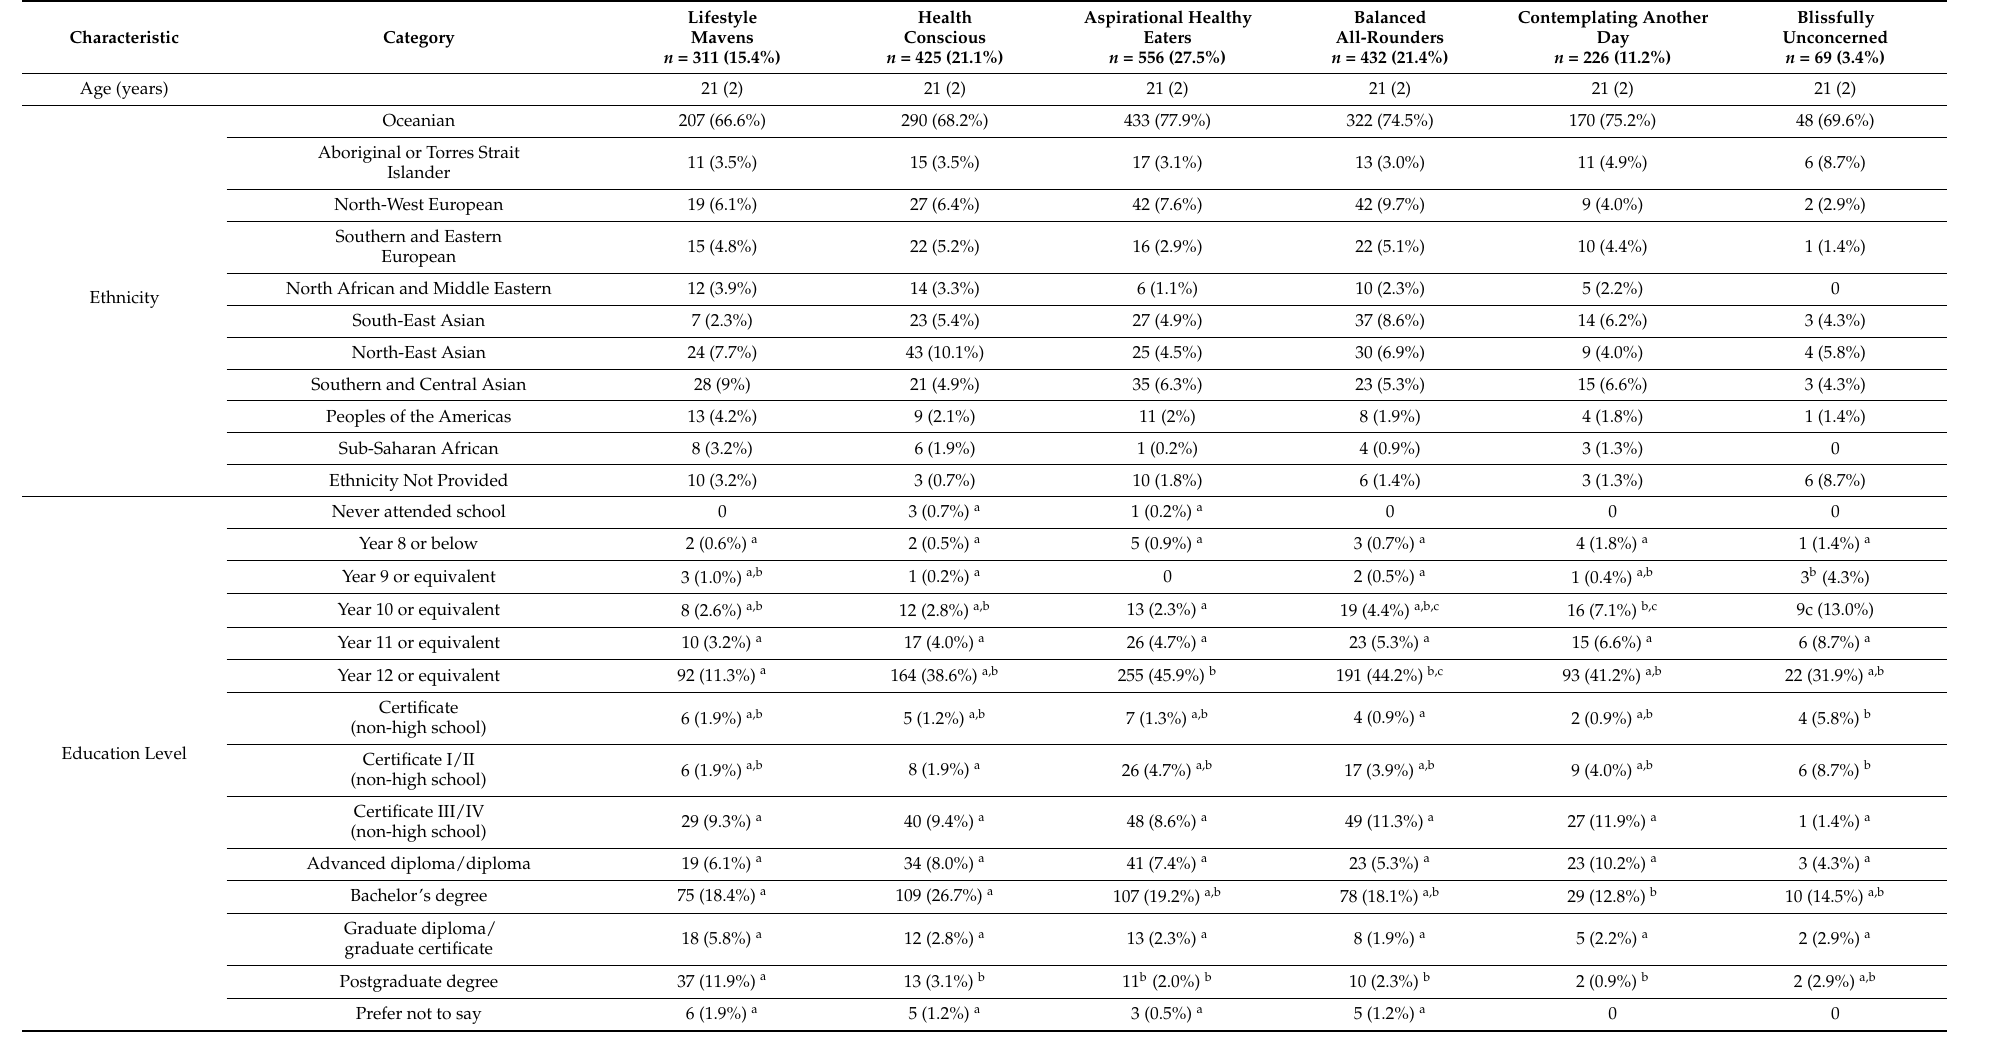
Table 1. Characteristics, demographics, and self-reported weight of Living and Eating Health Segments (LEHS) ( n =